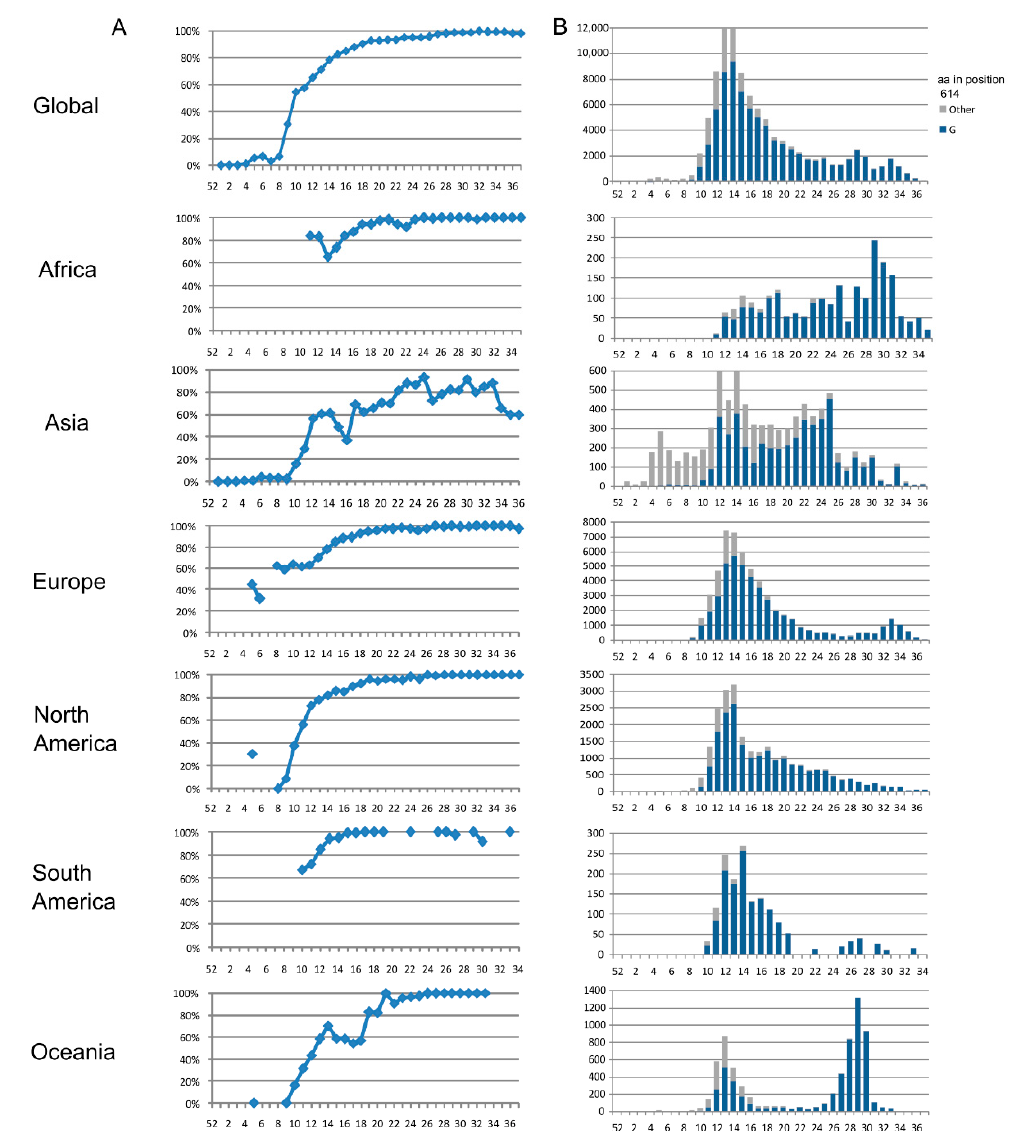
Figure 2. Global and regional frequency of D614G change in the spike protein over time. ( A ) Global and regional D614G frequency distribution in epidemiological weeks with, at least, 10 available sequences. The x -axis represents epidemiological week and the y -axis represents percentage of mutated sequences; ( B ) Global and regional number of sequences in spike’s residue 614 harboring aspartic acid and glycine amino acids in epidemiological weeks with at least 10 available sequences. The x -axis represents epidemiological week and the y -axis represents the number of sequences harboring other aa than G, in grey color, and G, in blue color.